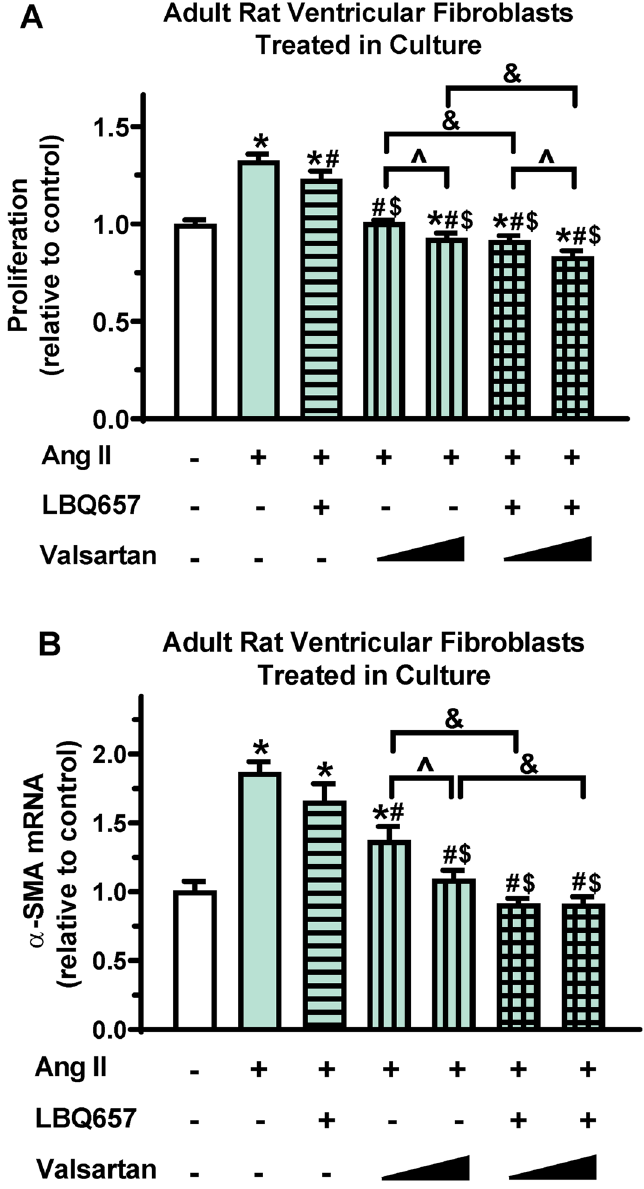
Figure 4. Sacubitril/valsartan is superior to valsartan in reducing Ang II-induced adult ventricular fibroblast activation in culture. Adult rat ventricular fibroblasts were pretreated with LBQ657 (10 µM), valsartan (0.3 or 1 µM) alone or the combination of LBQ657 (10 µM) and valsartan (0.3 or 1 µM) for 1 h before Ang II stimulation (1 µM, 72 h). ( A ) MTS cell proliferation assays normalized to vehicle controls (open bar, without Ang II, valsartan, and LBQ657). n = 8 determinations per group. ( B ) α-SMA mRNA expression normalized to 18S and expressed relative to vehicle controls. n = 6 determinations per group. Mean ± SEM. * P < 0.05 versus Control; # P < 0.05 versus Ang II; $ P < 0.05 versus Ang II + LBQ657; ^ P < 0.05 Valsartan at 1 µM versus 0.3 µM; & P < 0.05 for the indicated